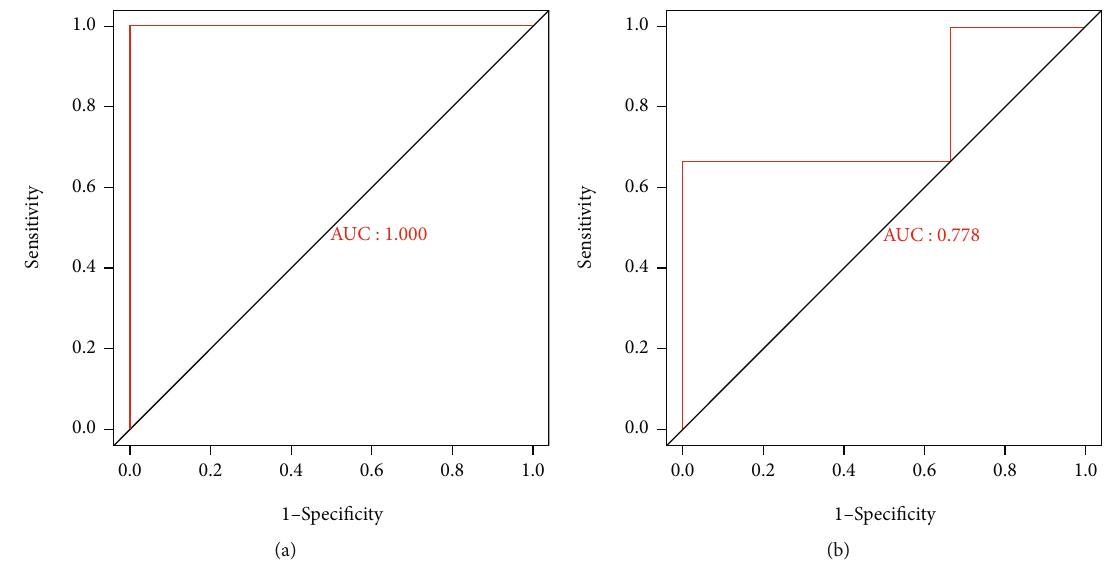
Figure 6: Results of ROC veri fi cation. (a) ROC curve of ATF2 in veri fi cation data set of GSE34095. (b) ROC curve of ATF2 in veri fi cation data set of